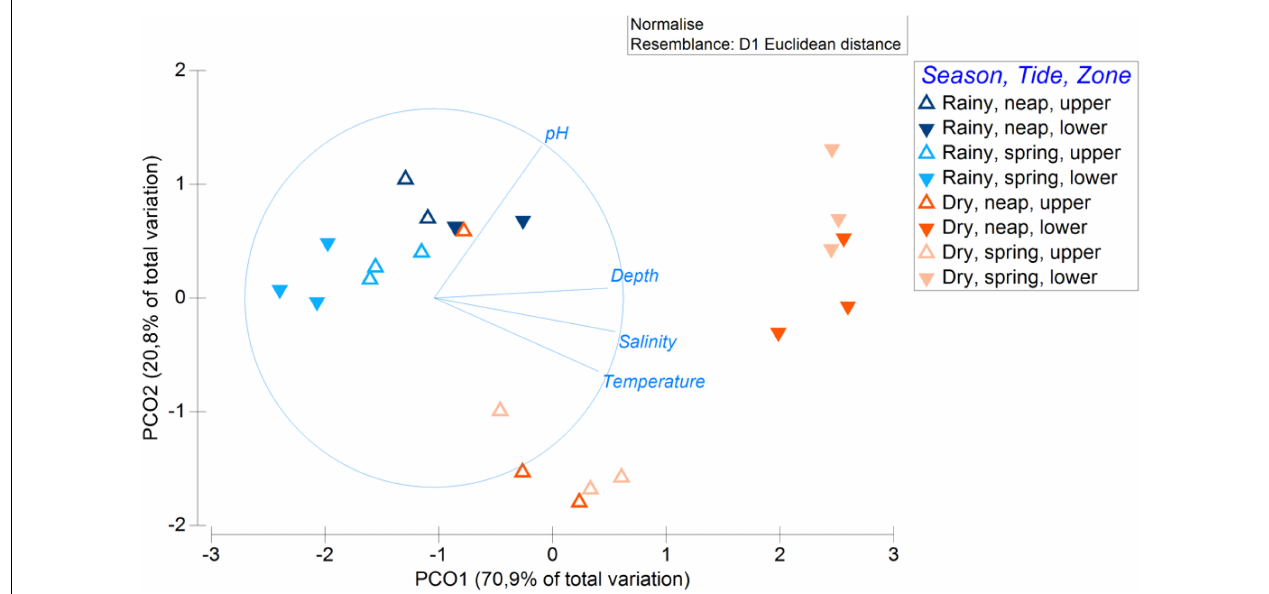
FIGURE 2 | Principal coordinates ordination (PCO) plot of the environmental data with differentiated points according to season (rainy and dry), tide (spring and neap), and mangrove zone (upper and lower). Environmental vectors inside the circle represent the gradients that characterize the points